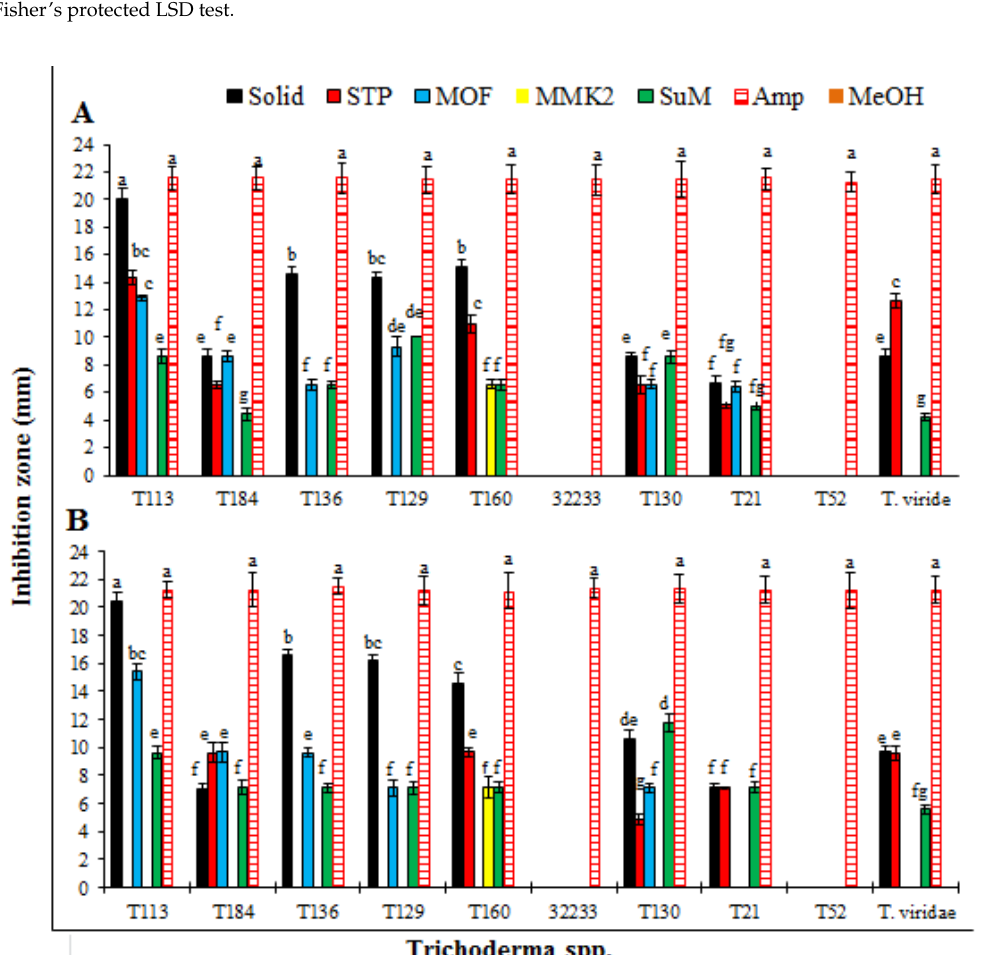
Figure 2. Growth inhibition (mm) of bacteria affected by SMs (obtained on different growth media) of Trichoderma spp. evaluated through the disc diffusion method. ( A) Growth inhibition of R. solanacearum ; ( B ) growth inhibition of X. compestris . Each value is a mean of three replicates. The bar represents the mean with standard deviation. Missing columns for some treatments indicated their 0.0 mm growth inhibition (or no activity). Treatments having similar lettering on the bar cha show no significant ( p ≥ 0.05) difference according to Fisher’s protected LSD test.